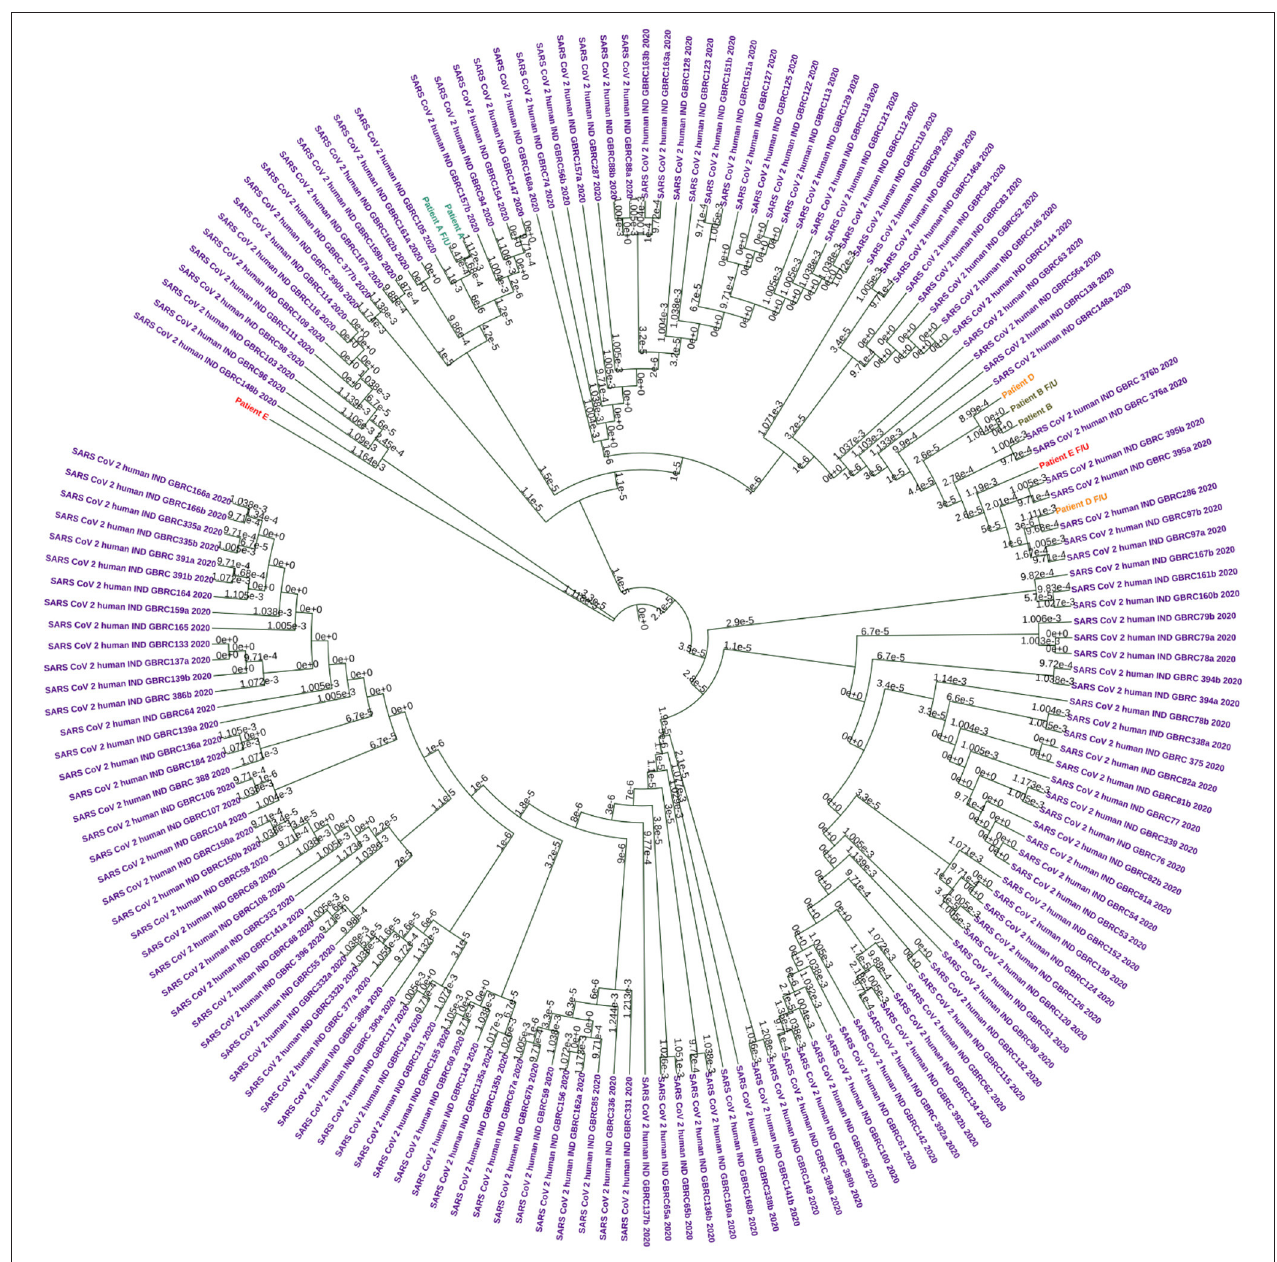
FIGURE 2 | Circular Phylogram generated using UPMGA on MEGAX. A total of 160 sequences were used in the analysis. Each patient sample pairs are colored. Patient A and f/u jade green, Patient B and f/u olive green, Patient D and f/u orange, and Patient E and f/u red. Sequences downloaded from the public database are colored in